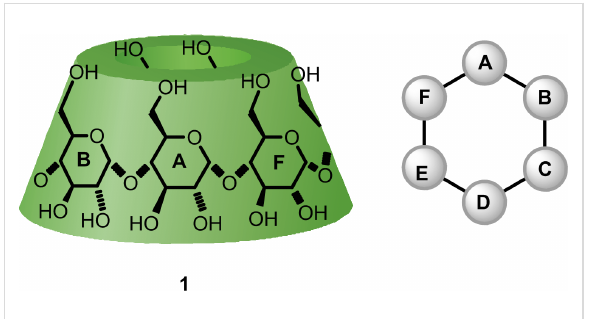
Figure 1: Schematic representation of native α -CD ( 1 ) and top view of its primary rim with alphabetic clockwise numbering of the glucose